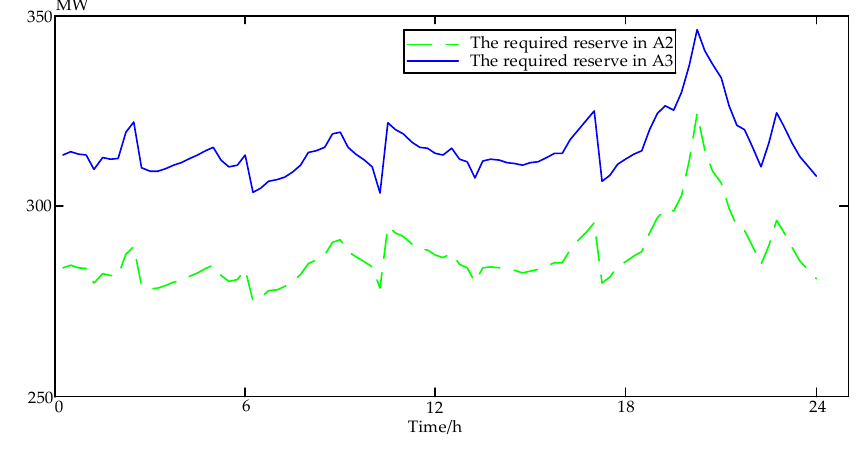
Figure 6. The required reserve for covering the risk. Energies 2018 , 11 , x